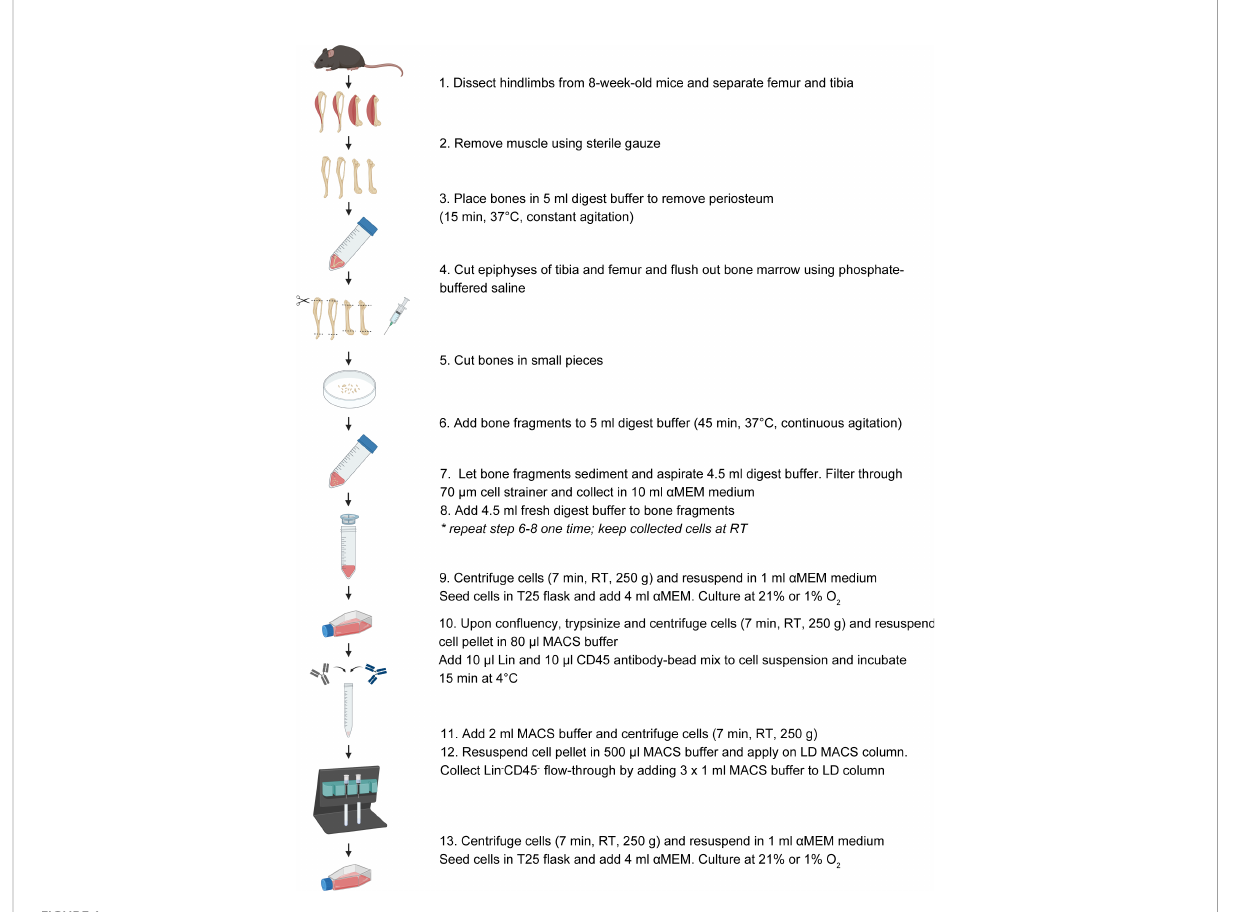
FIGURE 1 Schematic overview of the experimental setup to isolate long bone metaphyseal/endosteal SSPCs from young-adult